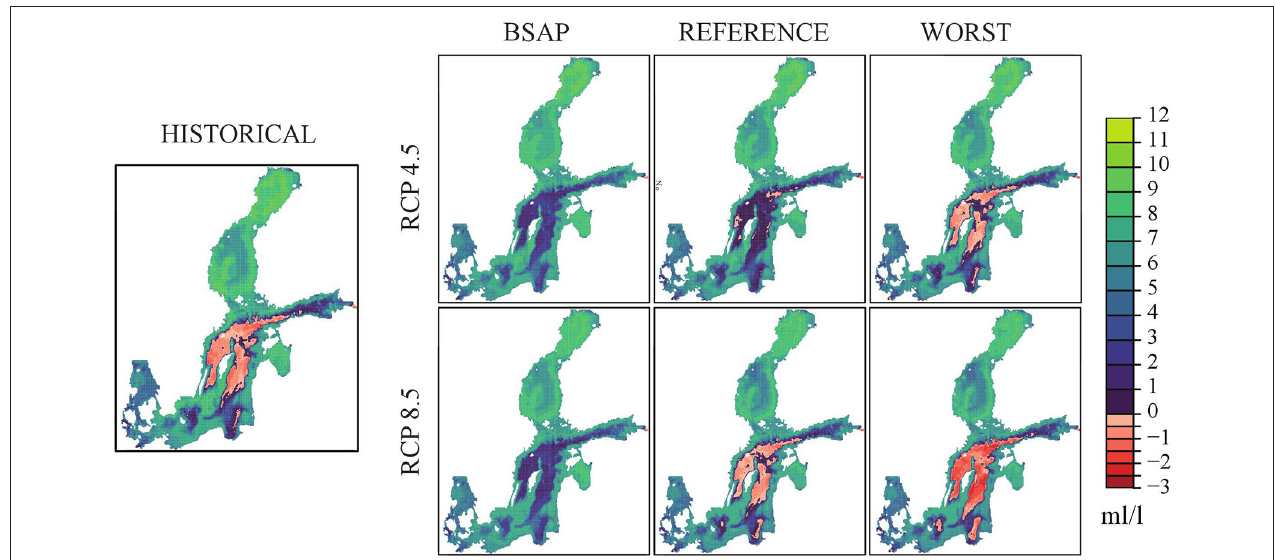
FIGURE 8 | Historical (1976–2005) and projected future (2069–2098) ensemble mean summer bottom oxygen concentrations (in mL L − 1 ) in three nutrient load (BSAP, Reference and Worst Case) and two greenhouse gas concentration scenarios (RCP 4.5 and 8.5). Hydrogen sulfide concentrations are represented by